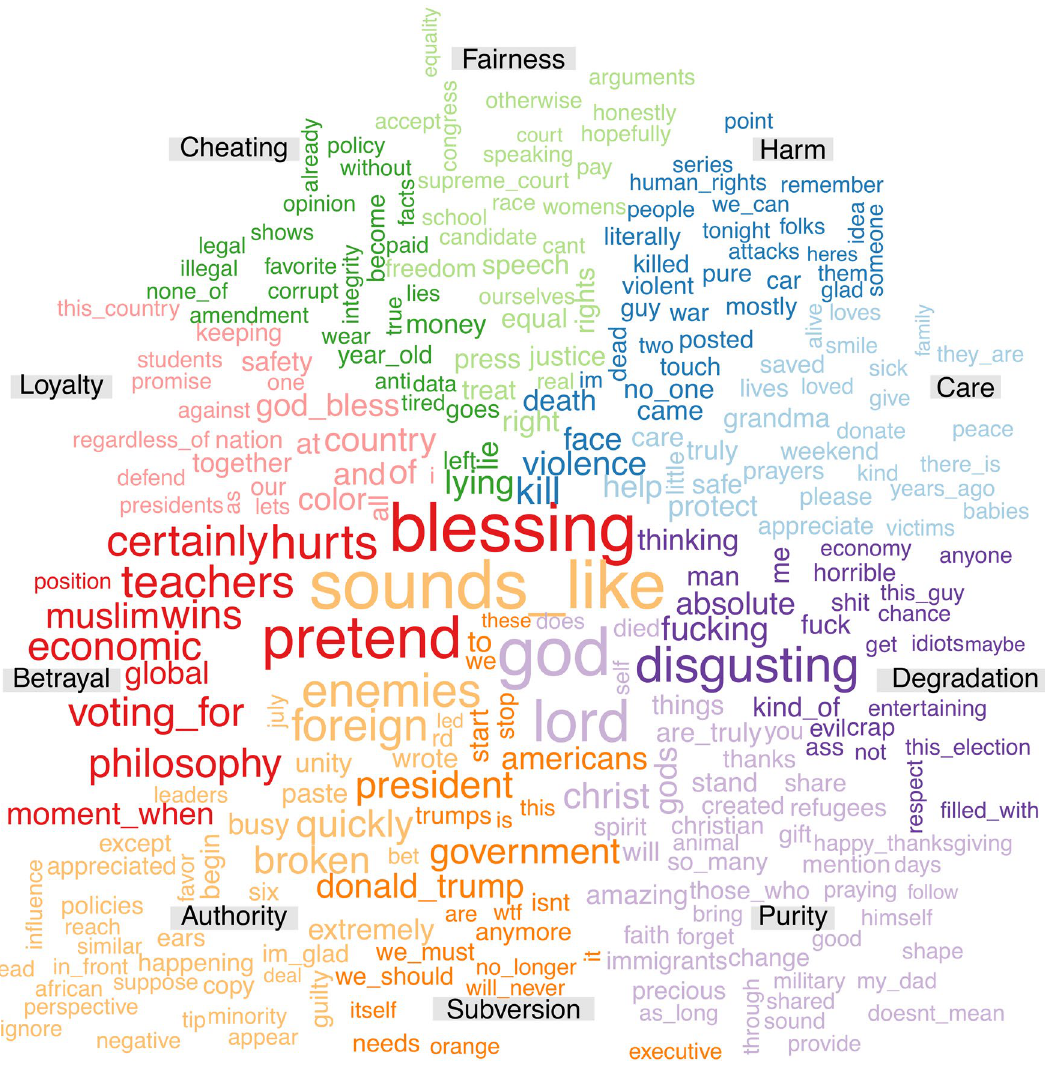
Figure 4. Visualization of the most salient words used in each category within moral posts (Study 3). Colors indicate the respective category as marked by each label, while the size of words is proportional to their weight in predicting the label across